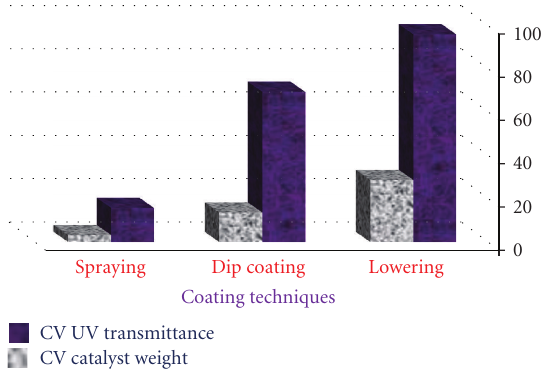
Figure 9: A comparative chart for the coe ffi cient of variation of the catalyst weight coated on a substrate and UVA transmission percentage in the lowering, dip coating, and spraying techniques.